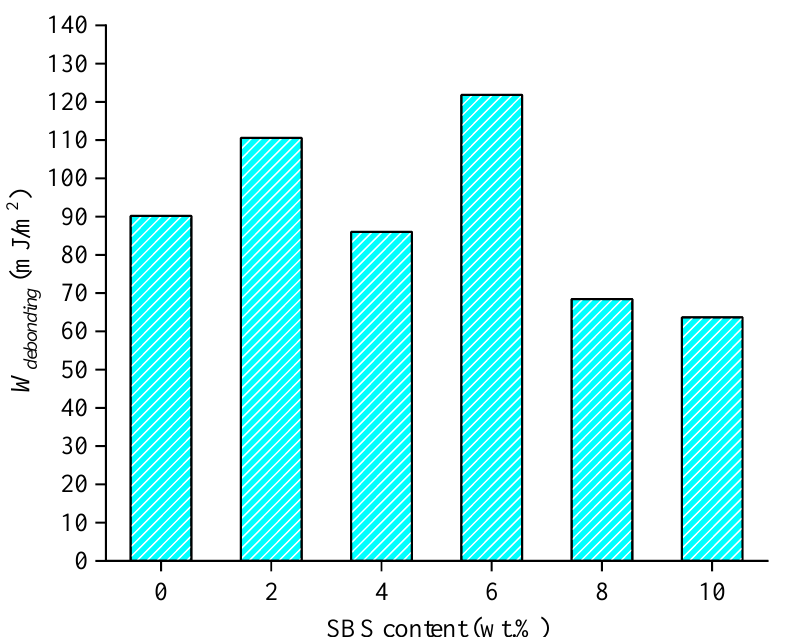
Figure 8. Variation in work of debonding with SBS content.